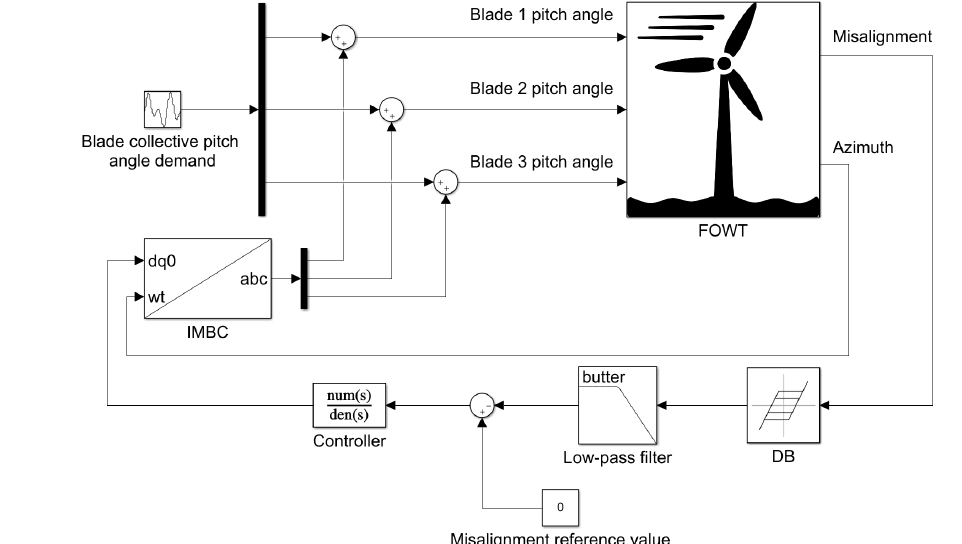
Figure 9. Yaw-by-IPC control block diagram.